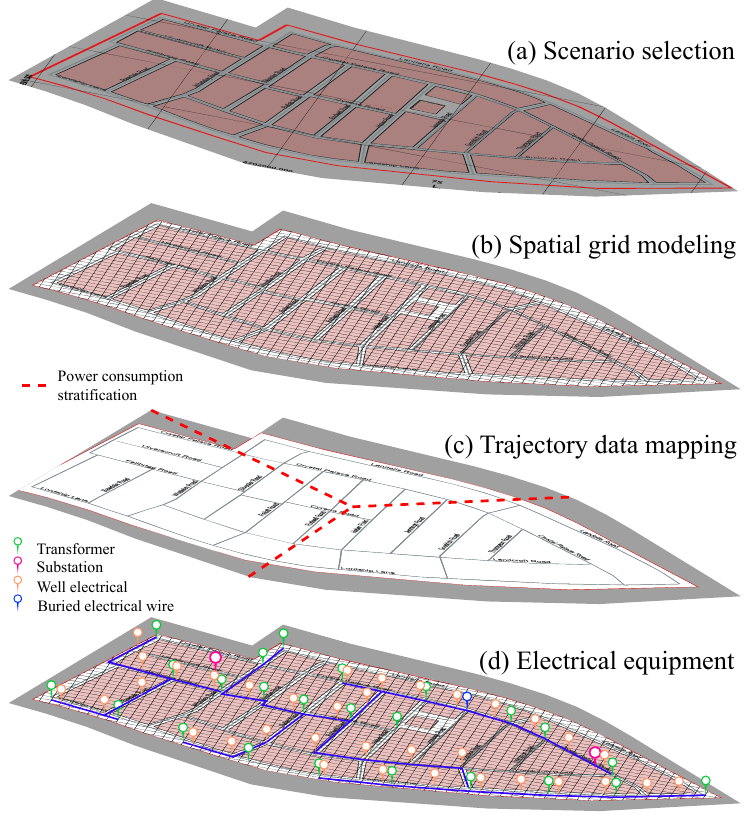
Figure 3. Layered evaluation of the proposed Methodology and